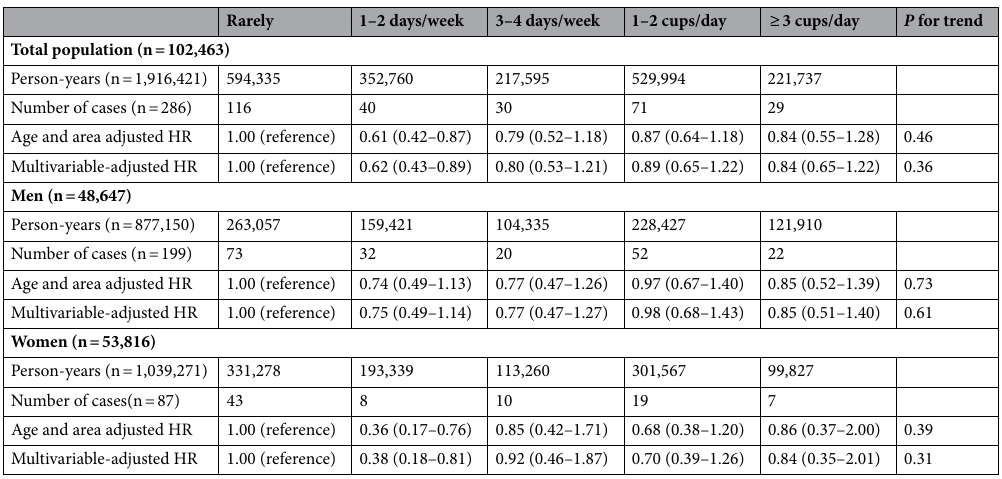
errors. Our results have shown a statistically significant reduced risk in the frequency of 1–2 cups of coffee per week with a HR of 0.62 (95CI%: 0.43–0.89) in the total population. The small number of cases could mask the true effect of a potential inverse relationship between coffee intake and kidney cancer. The foremost strength of our study was its large-scale prospective design including several public health center areas over Japan, along with a low proportion of loss to follow-up (0.4%). Therefore, the potential of recall bias and selection bias was largely reduced. Furthermore, the data from the comprehensive FFQ, and evaluation